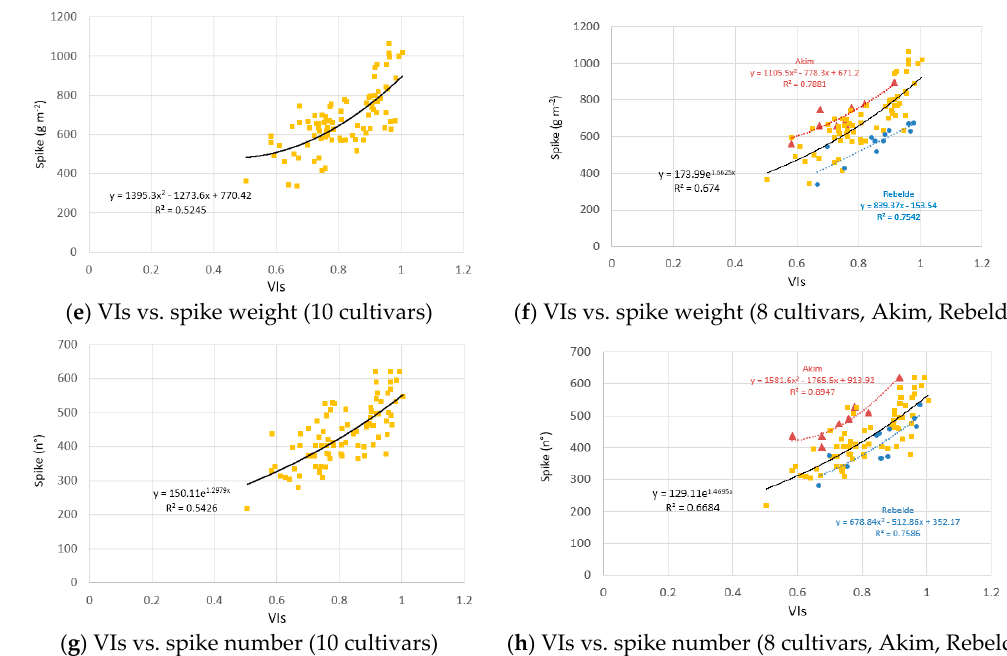
( e ) VIs vs. spike weight (10 cultivars) ( f ) VIs vs. spike weight (8 cultivars, Akim, Rebelde)